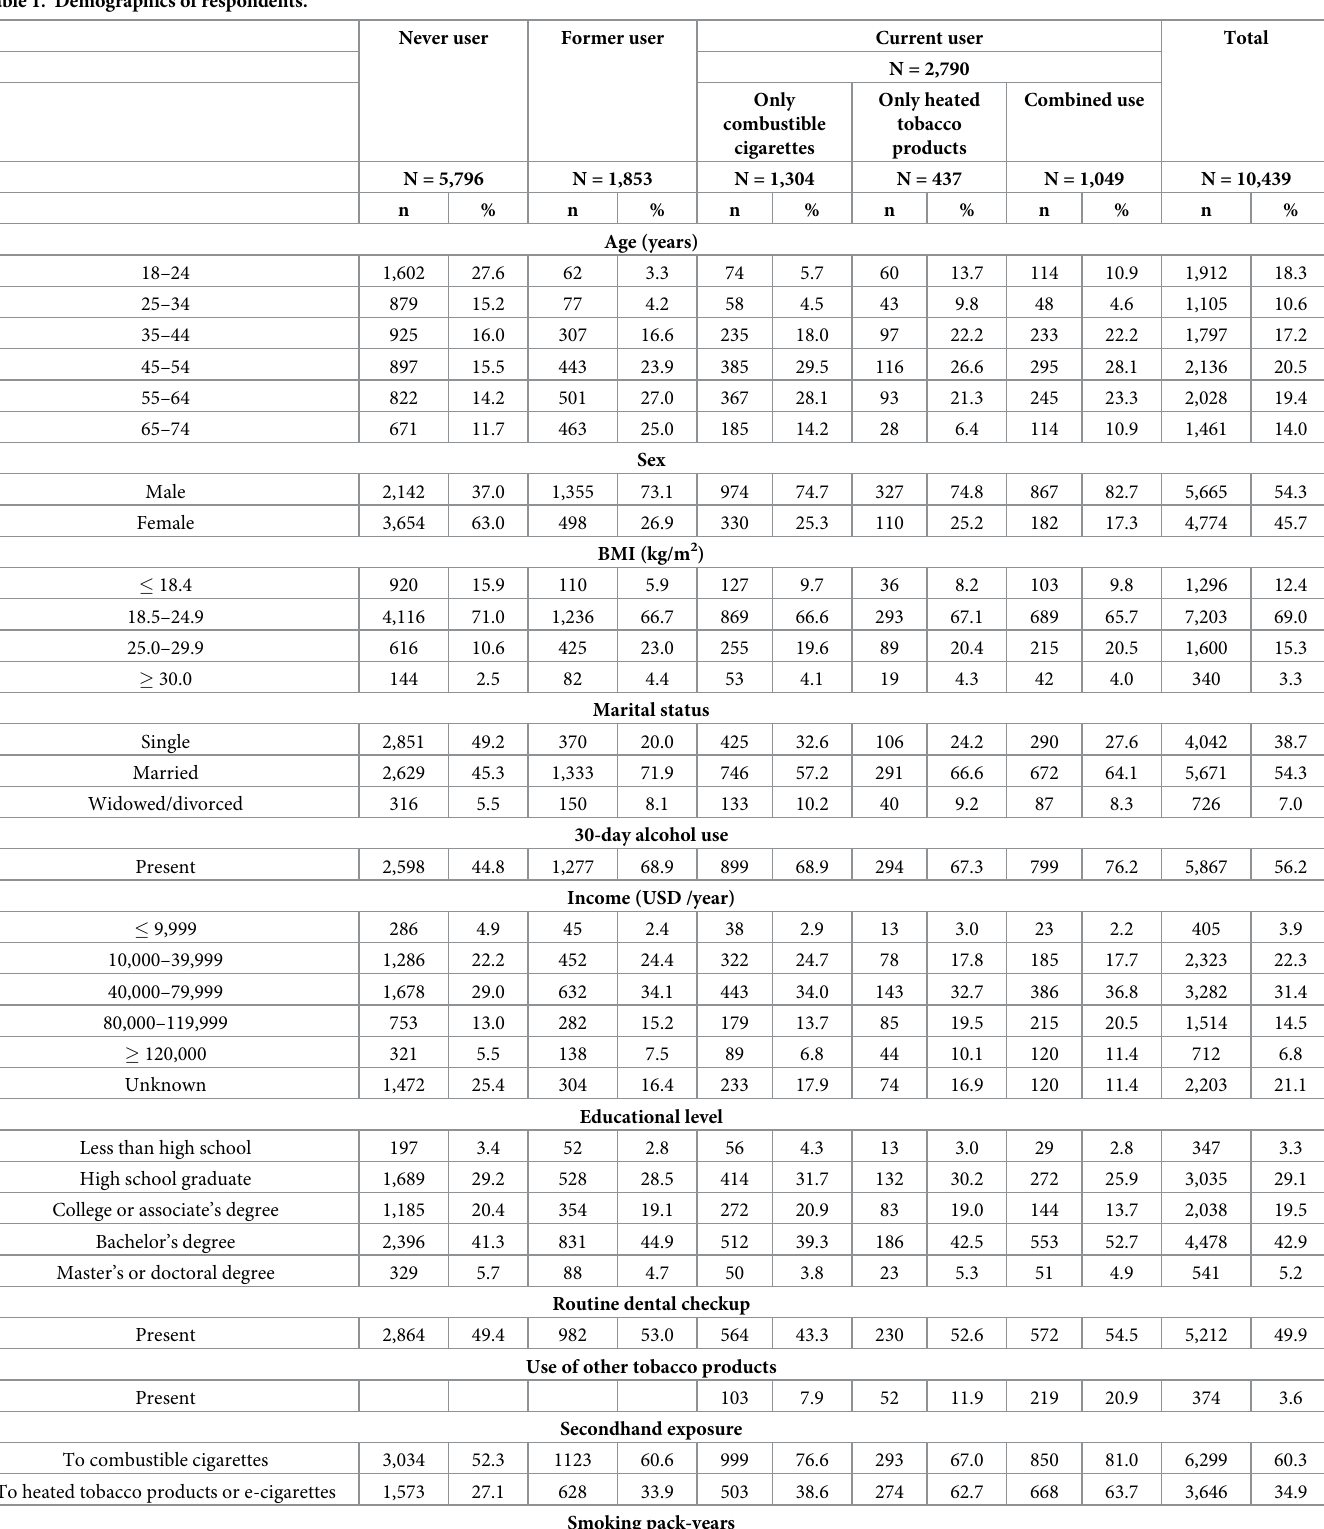
Table 1. Demographics of